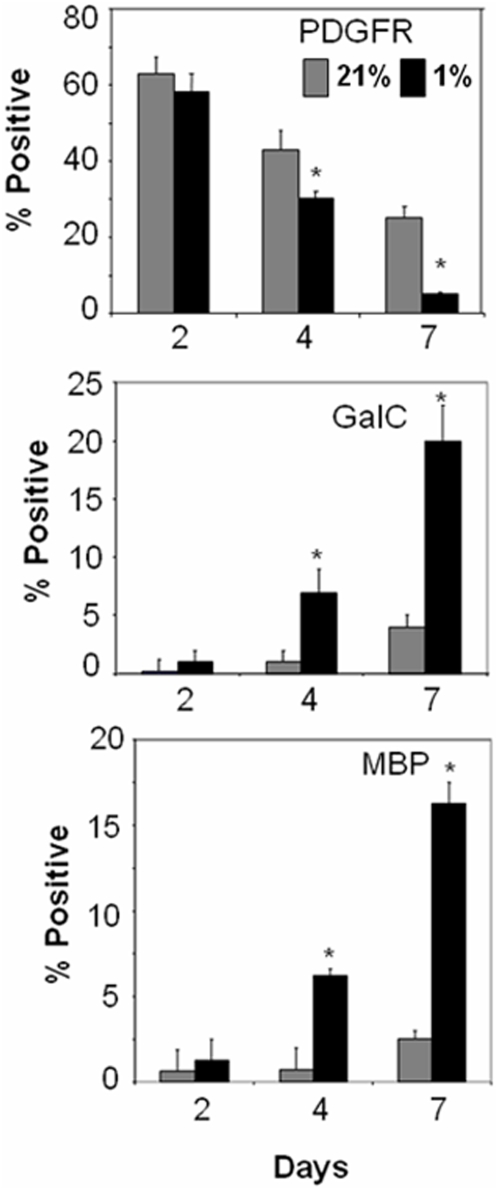
Hypoxia induces premature OL maturation.Percentages of cells that are positive for PDGFRα, GalC, or MBP cultured in 21% or 1% O2 plus GFs at 48 hrs, 96 hrs or 7 days in culture. * p<0.05 1% vs. 21% O2 at each time. Data shown are representative of three separate studies. At least three separate coverslips were analyzed per study.